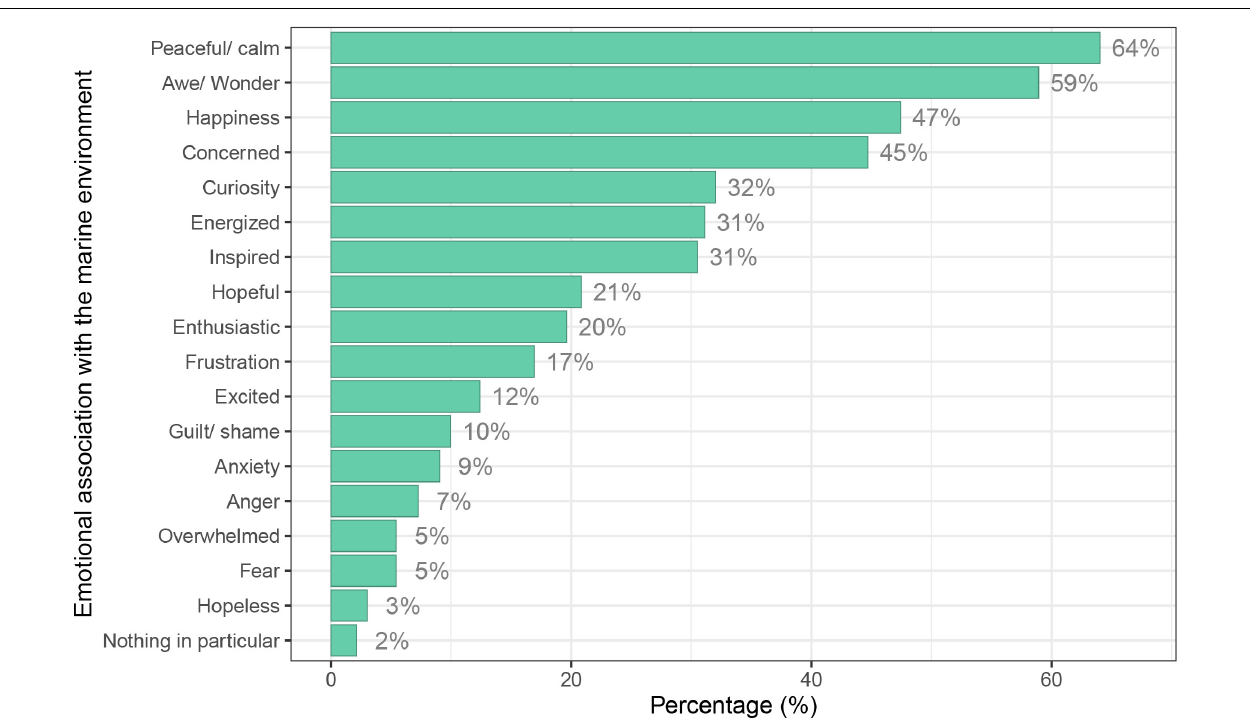
FIGURE 6 | Emotional associations with the marine and coastal environment ( n =